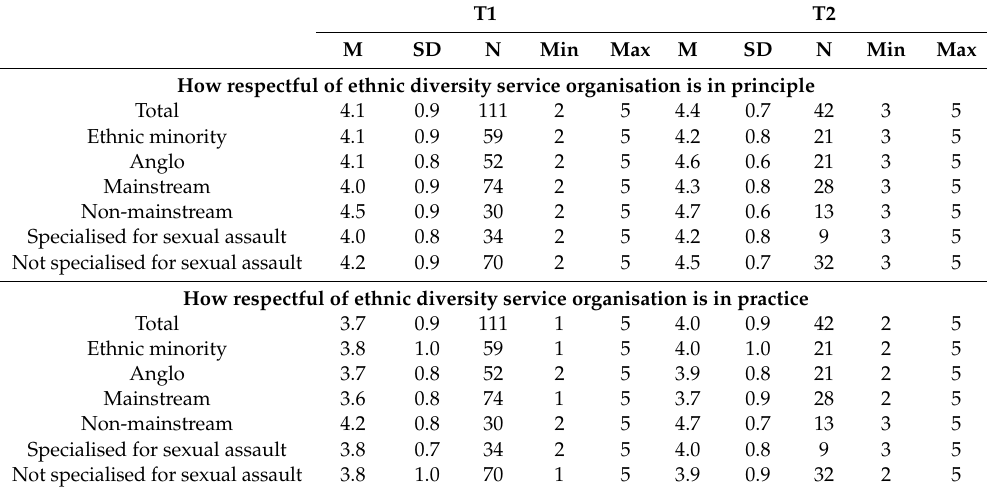
Table 6. Descriptive data on use of a multicultural